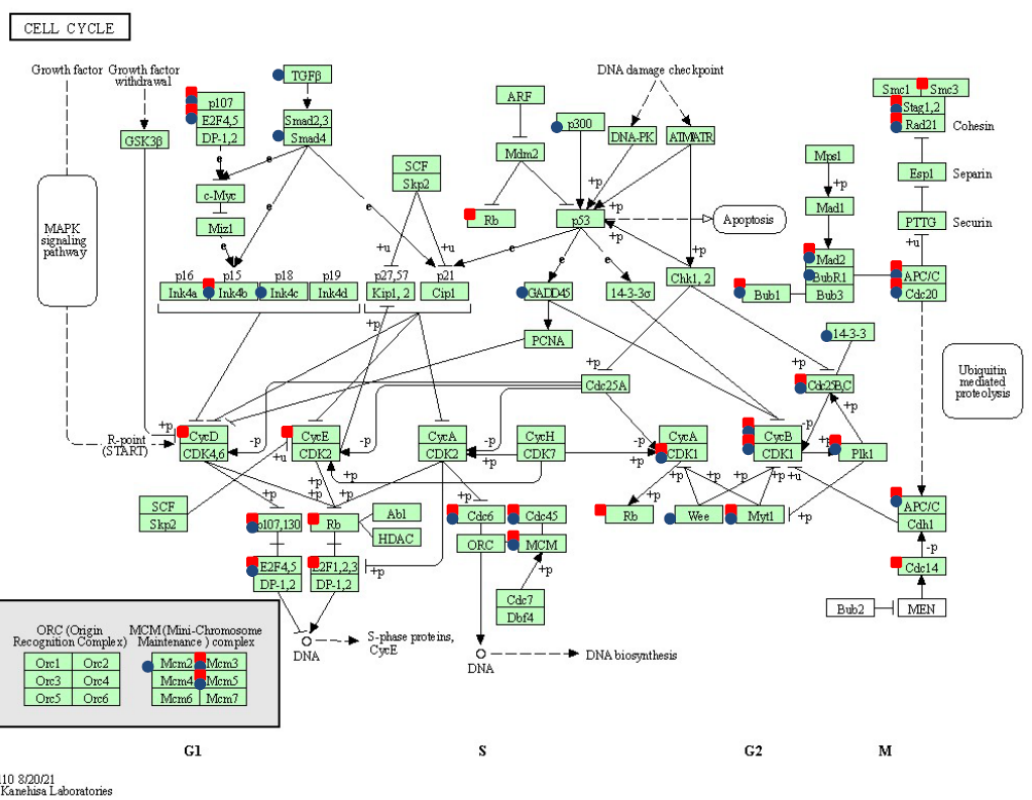
Figure 3. Cell cycle pathway (ecb 04110) over-represented following two strategies of sarcoid- dependent neoplastic transformation triggered by either BPV-E4 or BPV-E1ˆE4 transgenes. The red squares denote genes modified by BPV-E4 insert, while the blue circles indicate BPV-E1ˆE4 transgene- induced modifications; arrows present molecular interaction or relation, while dotted arrows show indirect link or unknown